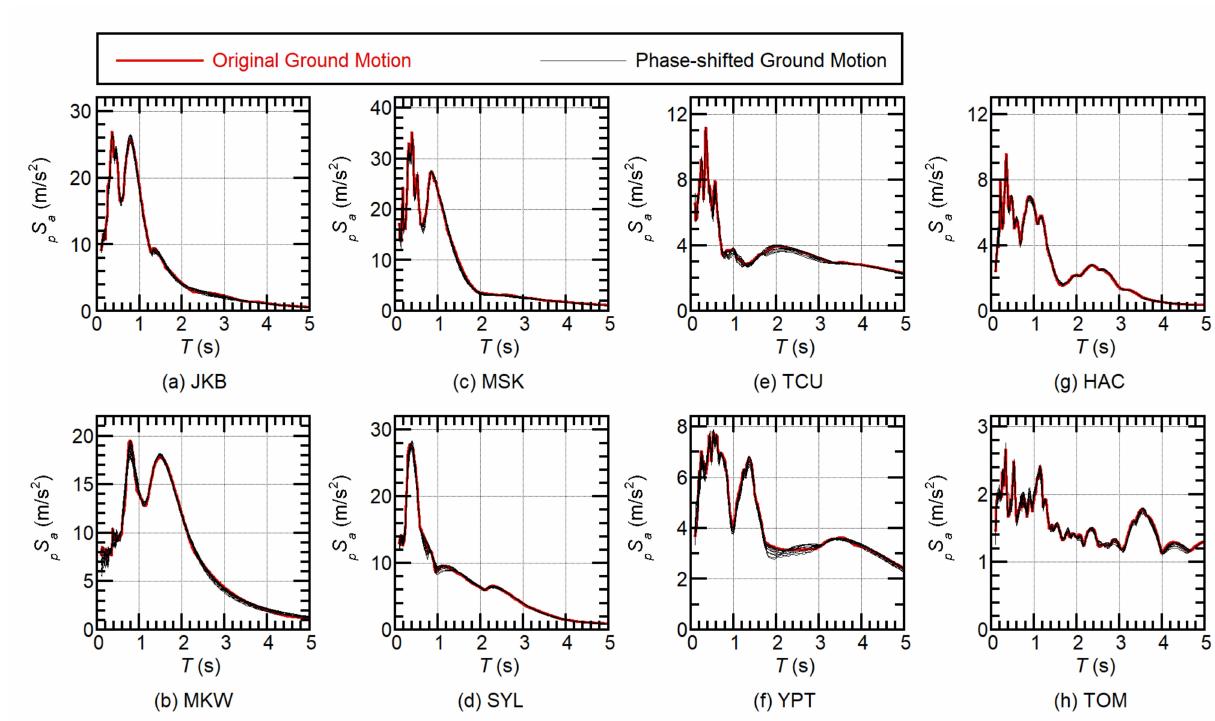
Figure 6. Linear bidirectional pseudo-acceleration spectrum calculated from the original and phase-shifted ground